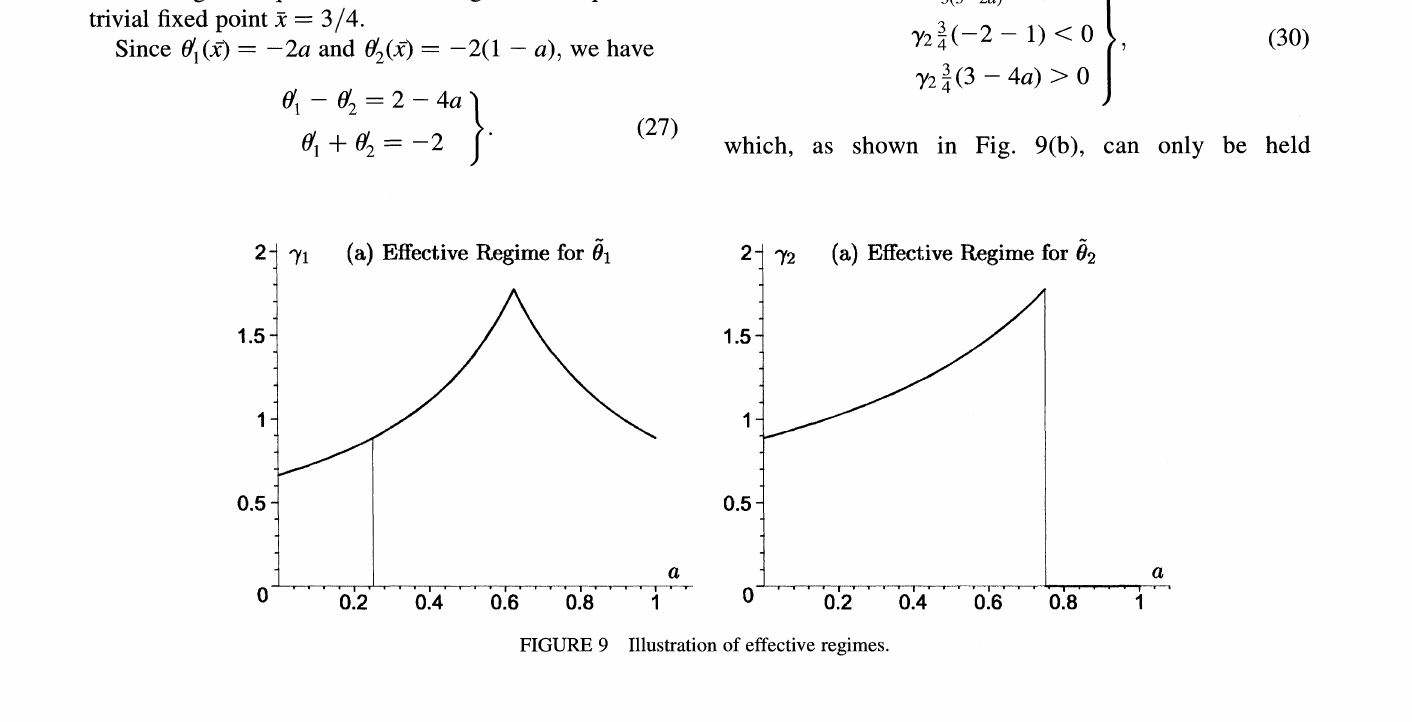
FIGURE 9 Illustration of effective